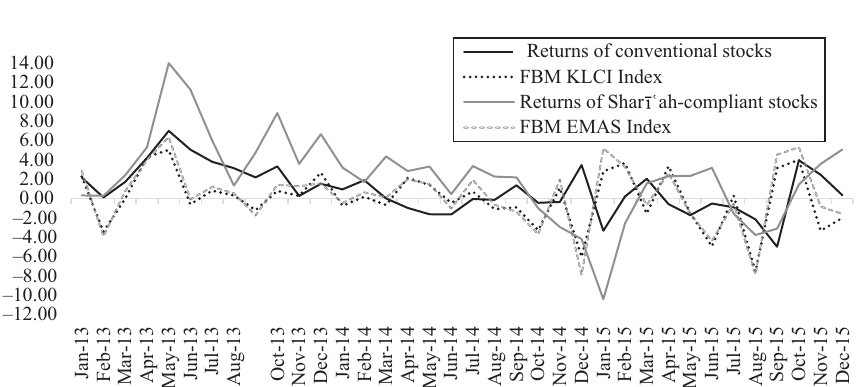
Table I. Summary of the ADF and PP tests